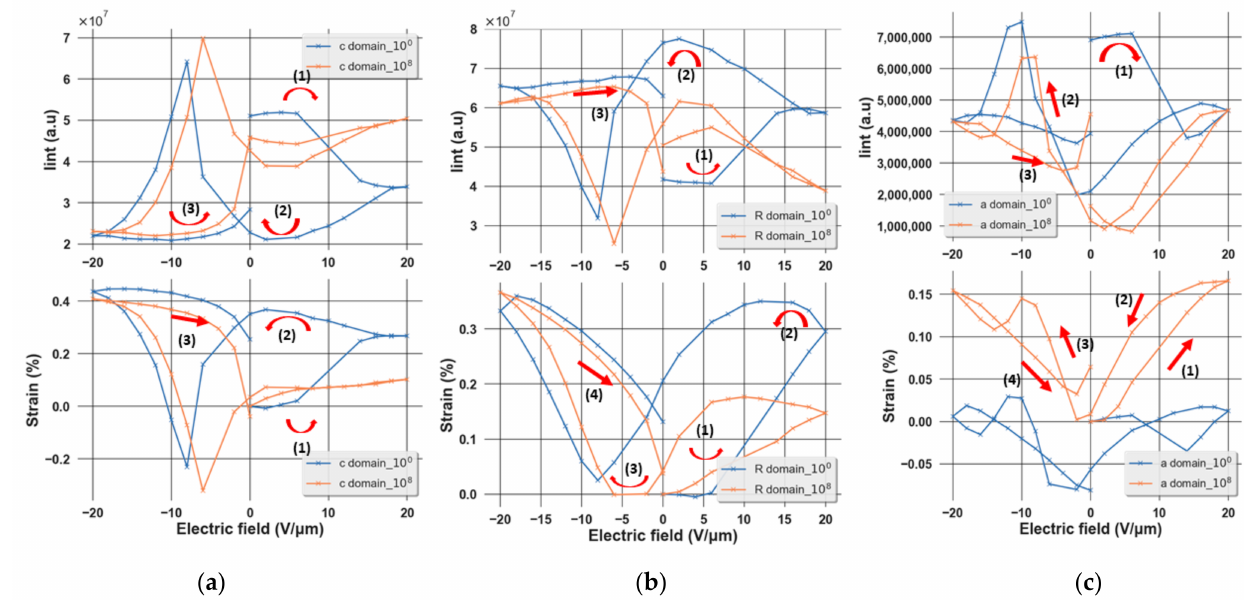
Figure 6. Variation of the peak area and strain of ( a ) the (002)T, ( b ) (024)R, and ( c ) (200)T phases as a function of an external electric